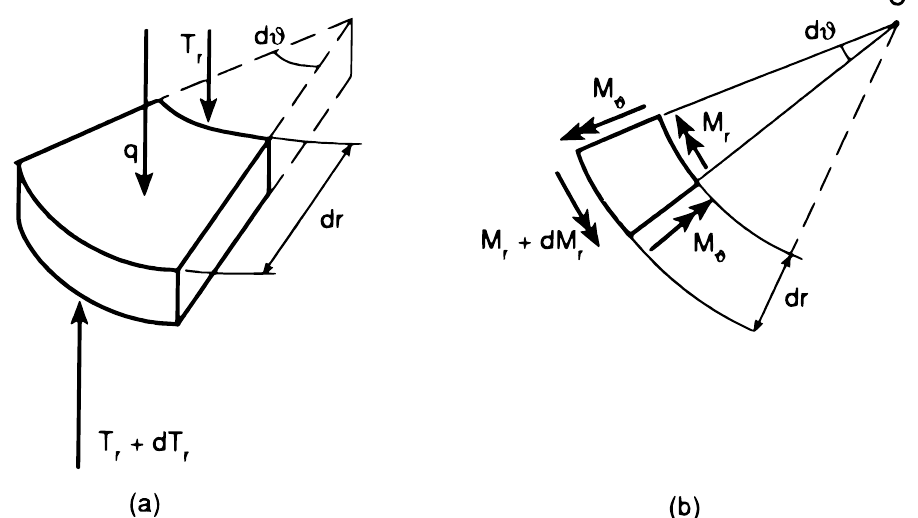
Figure 4: Circular plate: (a) equilibrium to the normal or transverse translation, (b) equilibrium to the rotation about the tangent to the cir-